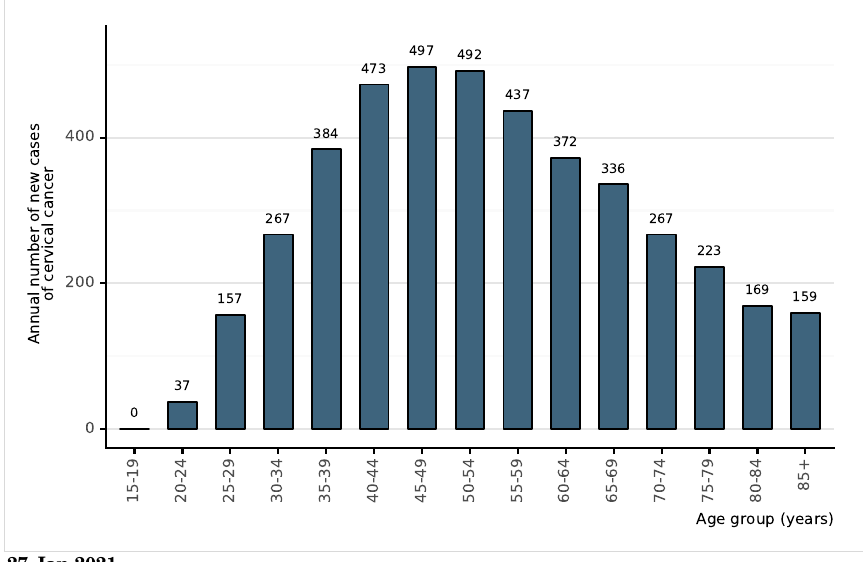
Figure 9: Annual number of new cases of cervical cancer in Peru (estimates for